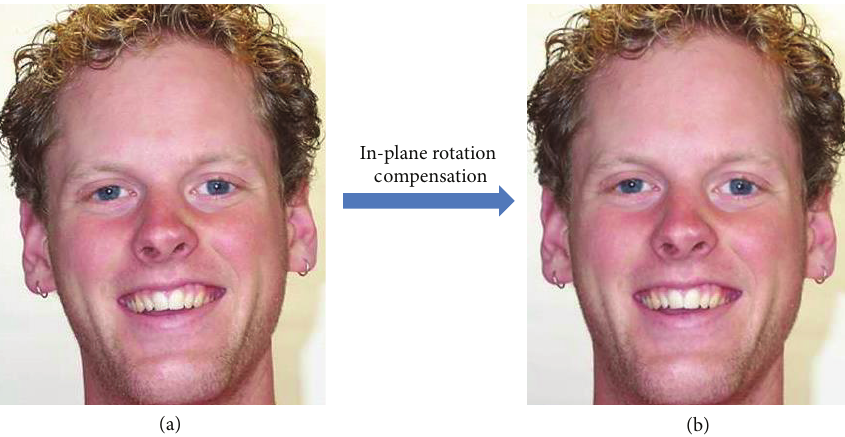
Figure 2: Example of in-plane rotation compensation: (a) an example rotated image and (b) in-plane rotation compensation result of the image in (a).